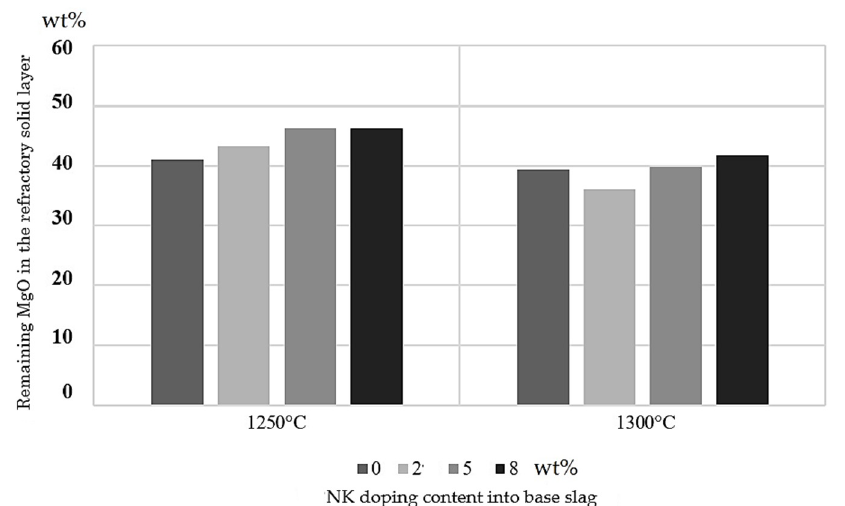
Figure 14. Magnesia content in the SLR on the hot face of the refractory in contact with NK-doped molten slag at 1250 and 1300 °C, measured by SEM-EDS.